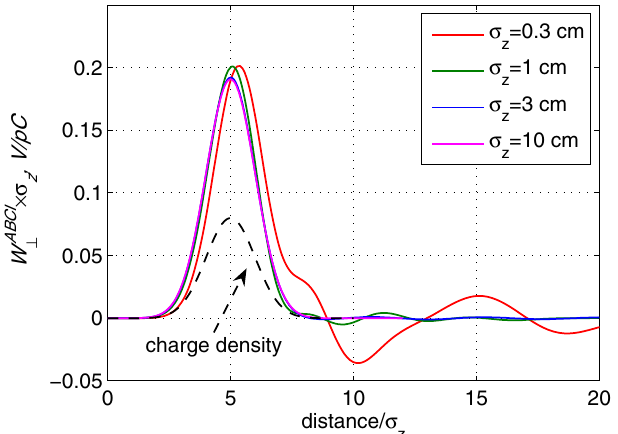
FIG. 6. (Color) Impedance calculated from ABCI using Eq. (B2) (color symbols), and linear interpolation to zero mesh size (dash). Geometry is that of Fig. 2, with " (cid:6) 7 = 11 and r 0 : 275 ( (cid:2) (cid:6) 173 mrad ).